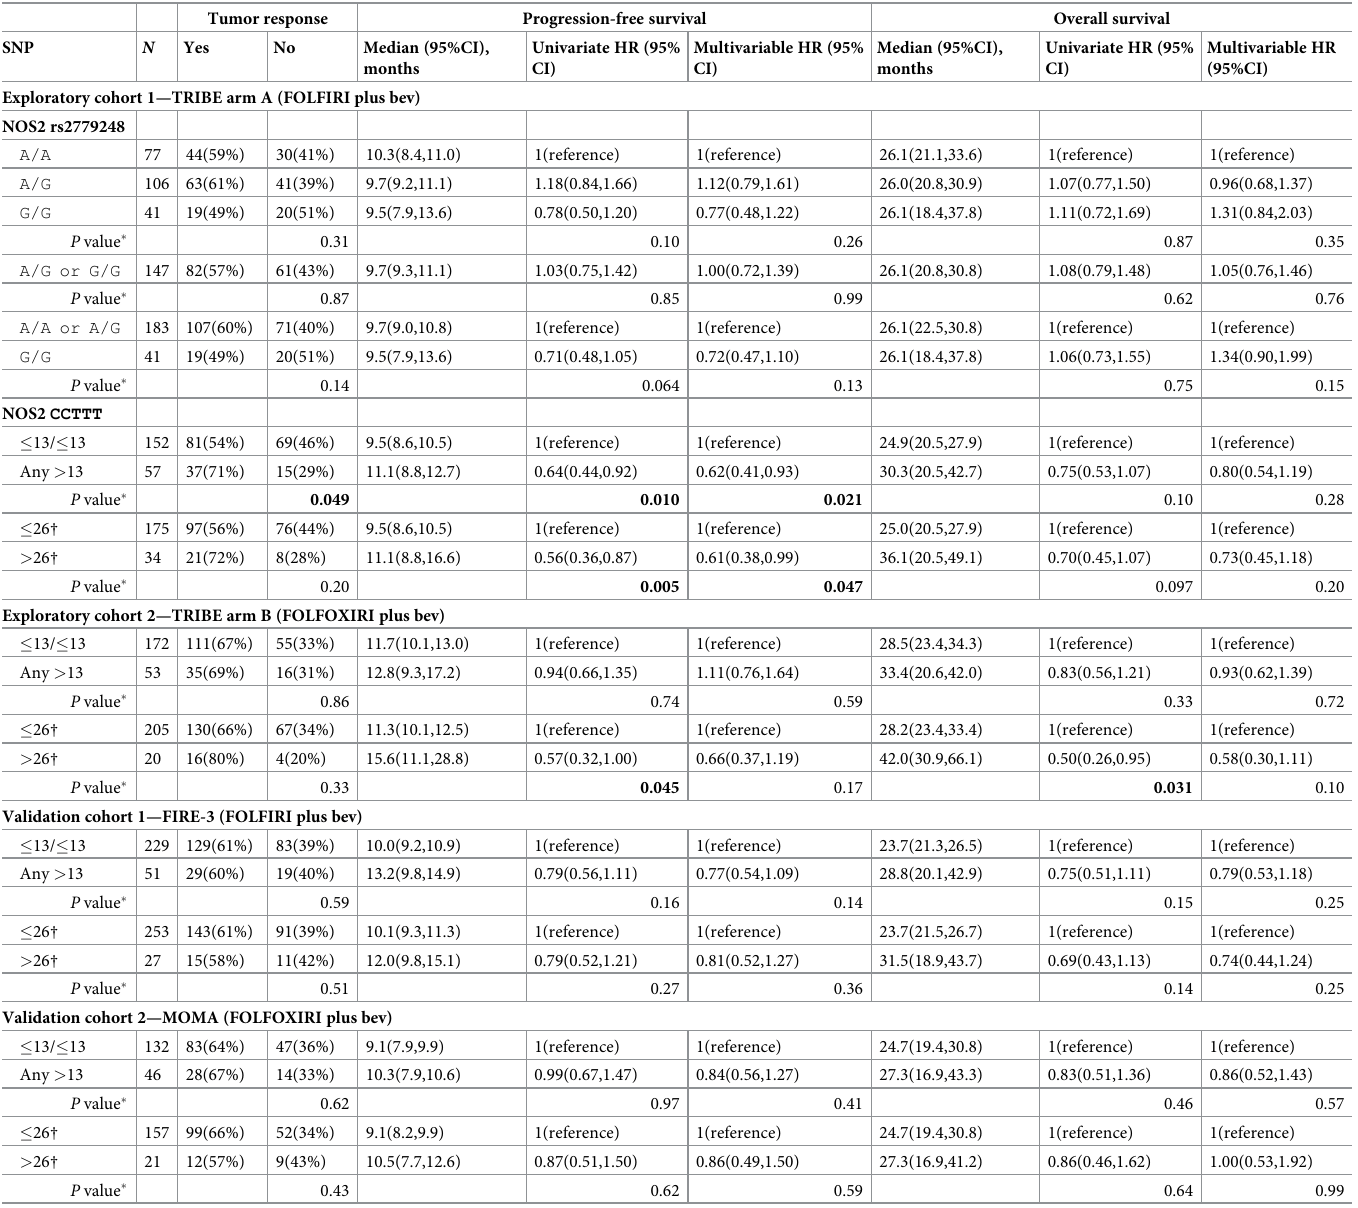
Table 3. Associations between CCTTT repeats and outcomes. Tumor response Progression-free survival Overall